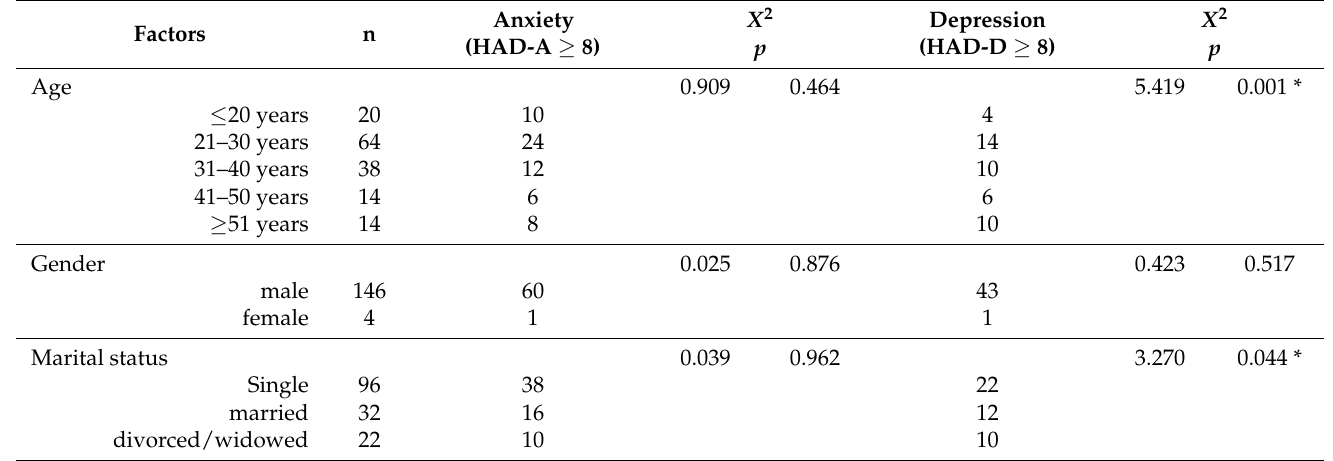
Table 2. Factors associated with anxiety and depression among patients with